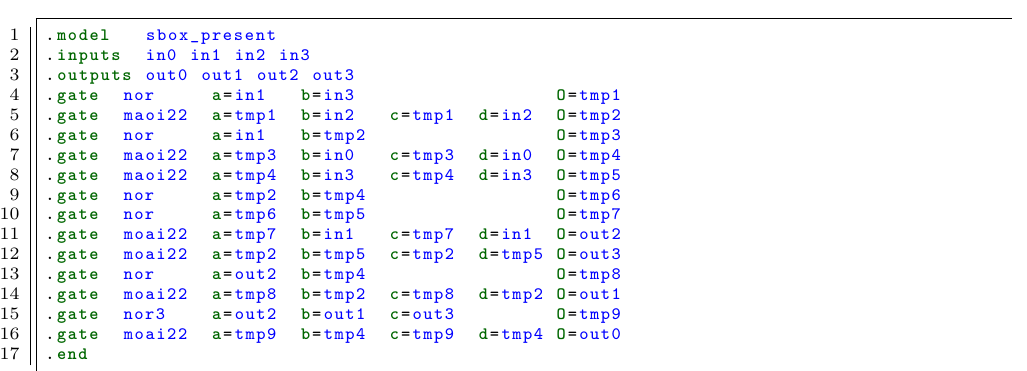
Figure 13: Area-optimized hardware implementation of PRESENT Sbox using 24.00 GE with the standard cell library of the TSMC 65nm logic process.